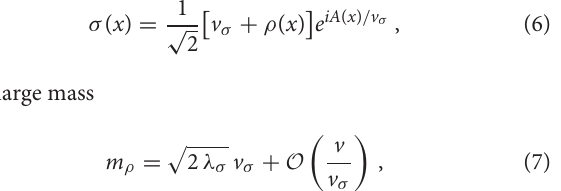
FIGURE 2 | Particle/field content of